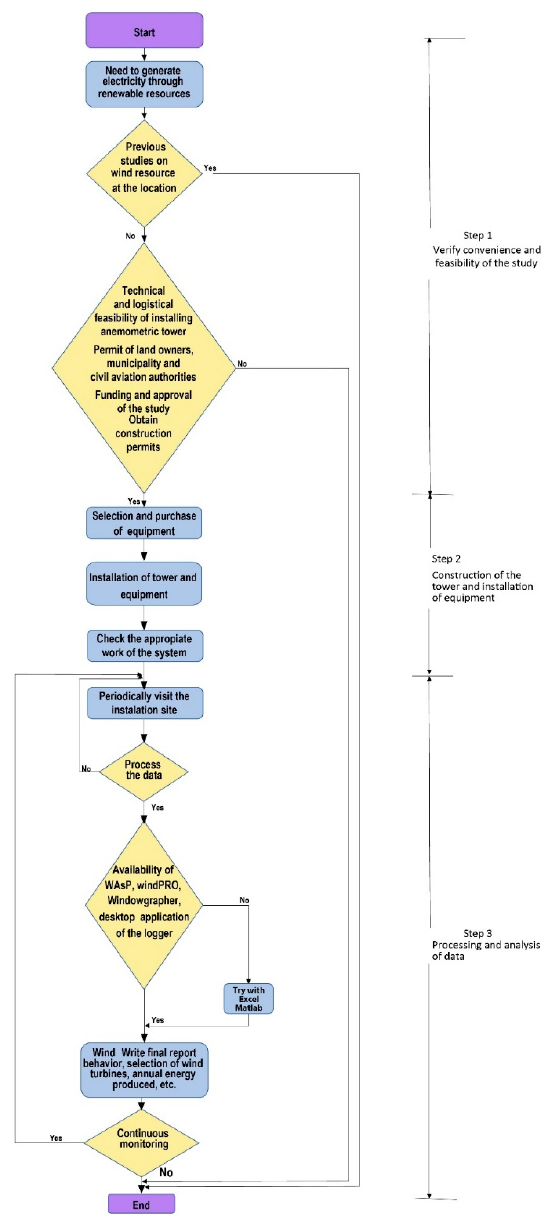
Figure 2. Methodology for studies on wind resource assessment.